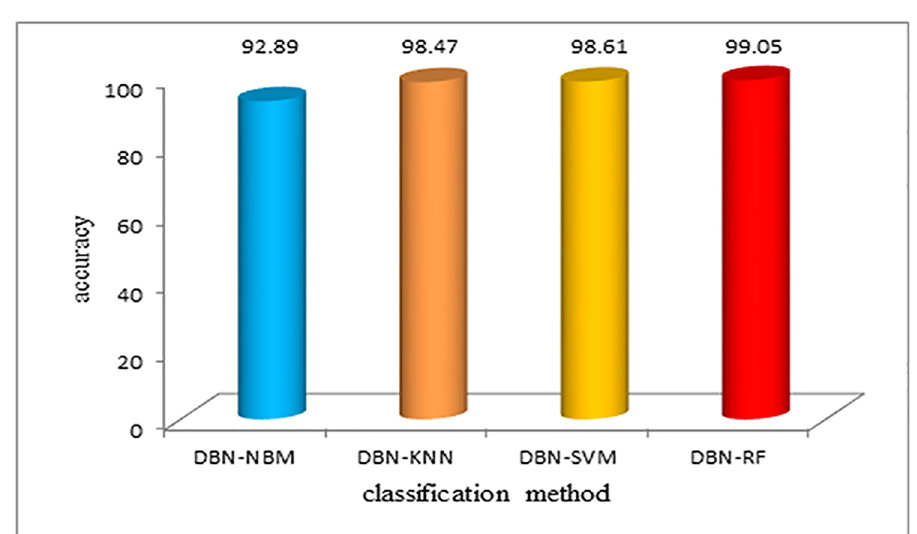
Fig 13. Classification accuracyusing different algorithms after DBN dimension reduction. When we used the DBN method to reduce the dimensionof the data, the classification performance of the four algorithms was greatly improved, which is shownin Fig 13. Most notably, the performance of the DBN-RF algorithmis especiallyprominent.